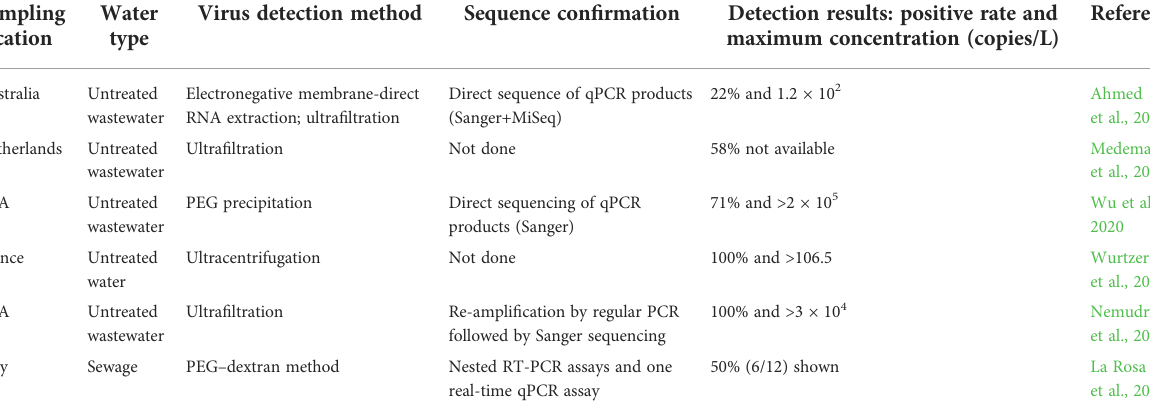
TABLE 2 Details of the reported molecular detection of severe acute respiratory syndrome coronavirus 2 (SARS-CoV-2) in wastewater. Sampling